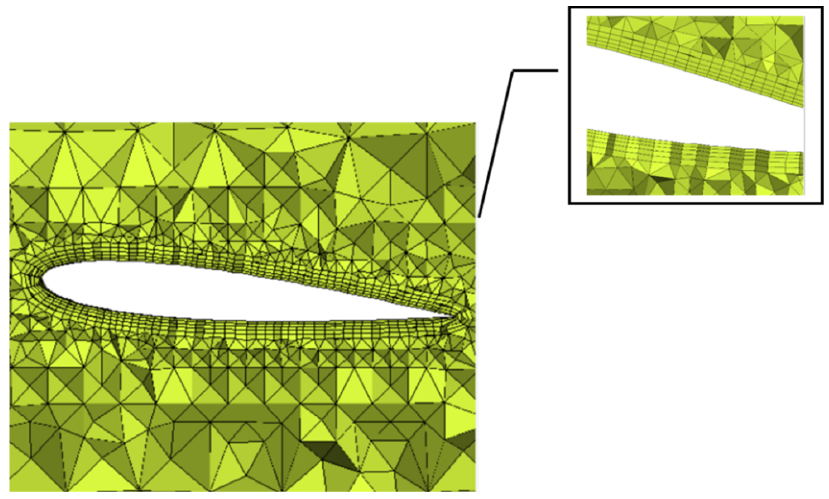
Figure 9. Grid division of boundary layer.